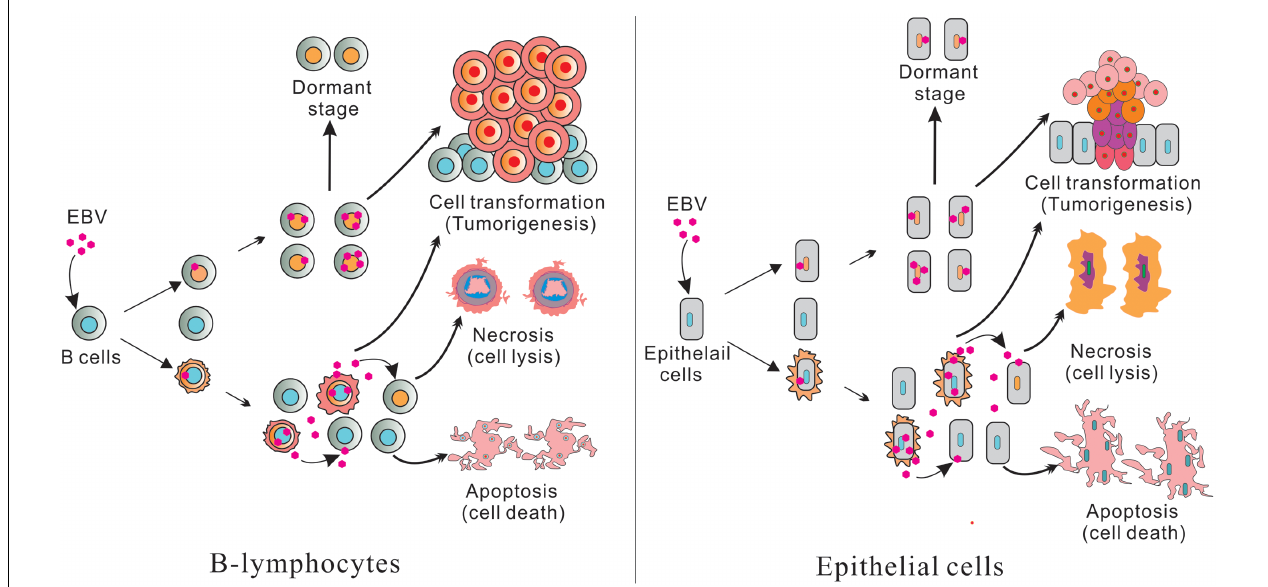
FIGURE 1 | (Left) Represents B-lymphocytes infection and (Right) epithelial cell infection. Epstein–Barr virus (EBV) infected B-lymphocytes and epithelial cells have pools of uninfected and infected cells. Further, some cells produce infectious virus which can infect new cells. The remaining cells will die through apoptosis and necrosis. A portion of the infected cells are transformed and leads to tumorigenesis through cell transformation. Some infected cells are also switched to a dormant stage and can be activated or reactivated when conditions are favorable for lytic replication.